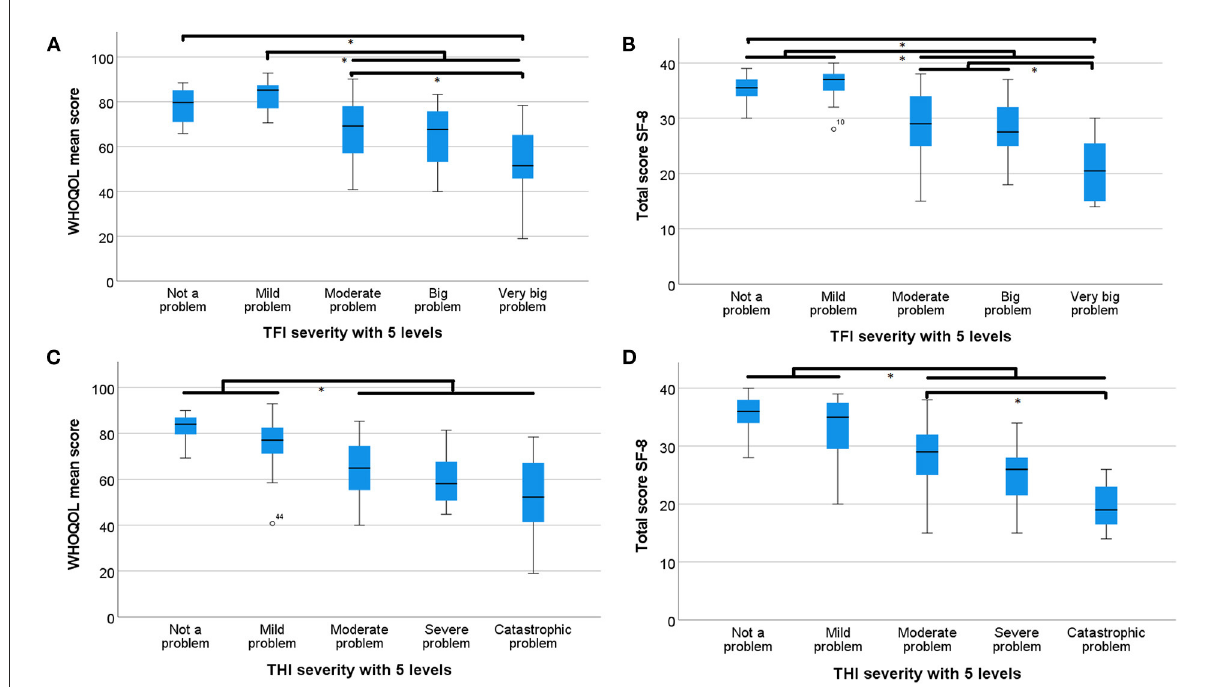
FIGURE4 Boxplots of TFI and THI severity categories. TFI and THI severity categories and the median, minimum, maximum, and interquartile of WHOQOL-BREF and SF-8 are shown. * indicates a significant difference. (A) TFI severity categories vs WHOQOL-BREF scores, (B) TFI severity categories vs SF-8 scores, (C) THI severity categories vs WHOQOL-BREF scores, and (D) THI severity categories vs SF-8